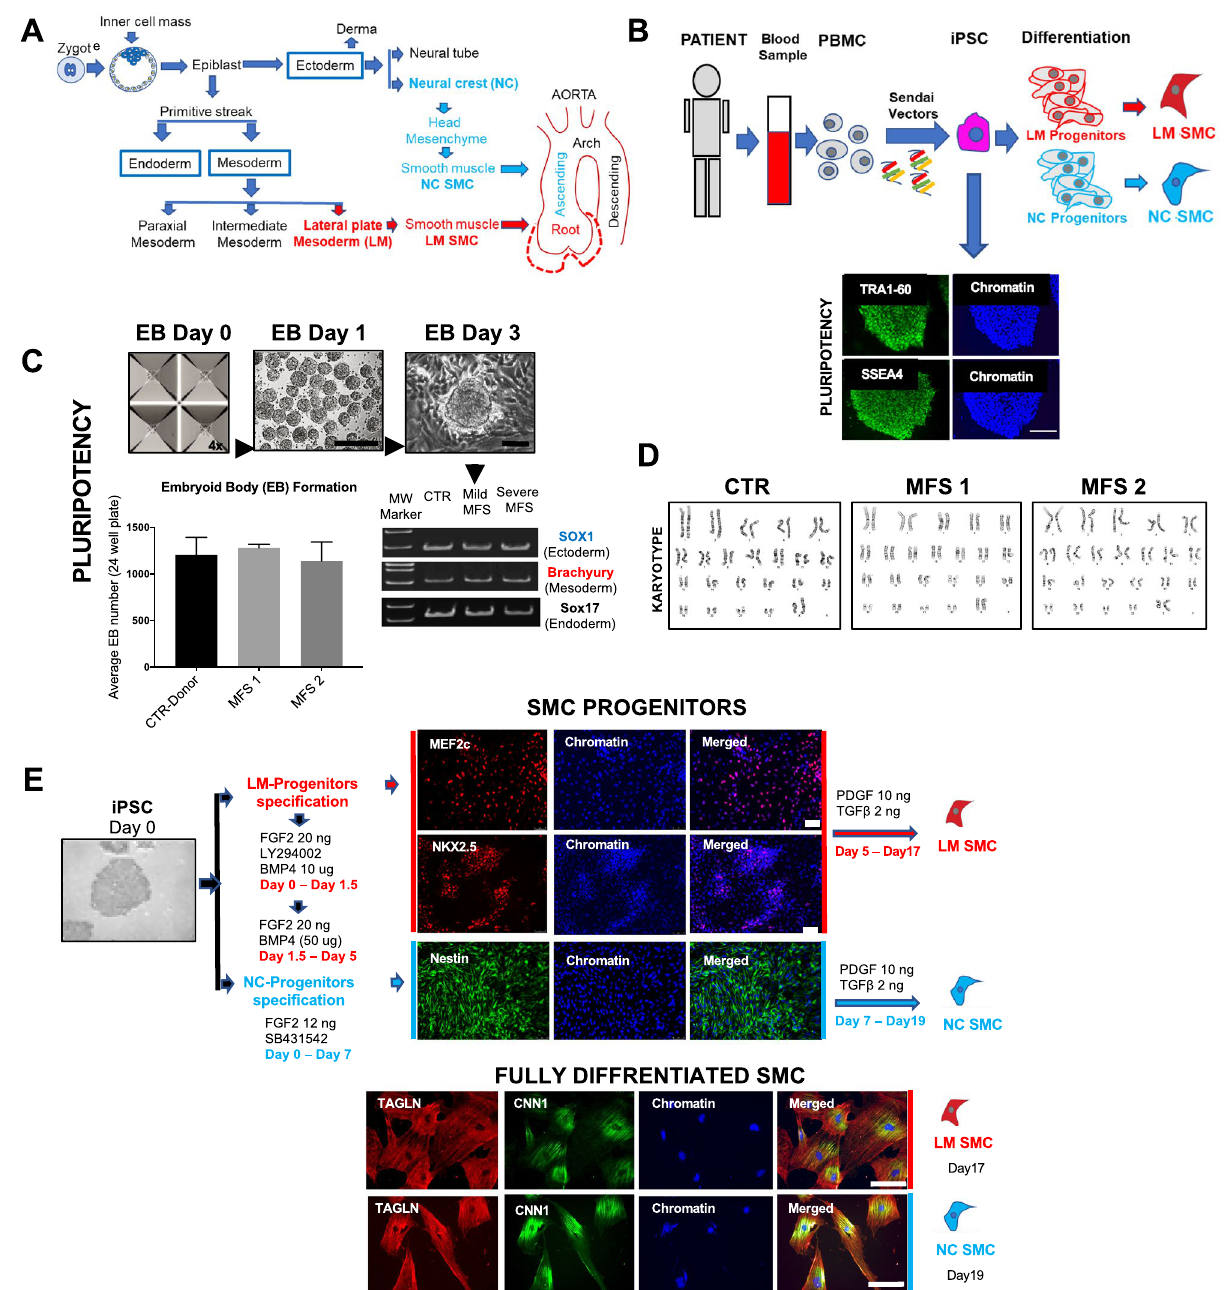
Figure 1. Peripheral blood mononuclear cells (PBMC) derived iPSCs differentiated into vascular smooth muscle cells (SMC) can model Marfan syndrome disease, in vitro. ( A ) Brief description, lineages contributing SMCs to the thoracic aorta. While lateral mesoderm (LM) SMCs contribute to the aortic root structure, neural crest (NC) SMCs populate the ascending aorta. ( B ) PBMC reprogramming with Sendai virus vectors of OCT4, SOX2, Nanog and cMyc transcription factors to generate induced pluripotent stem cells (iPSC) which were further differentiated into LM and NC SMC progenitor cells. IPSCs stained positively for pluripotency markers TRA1-60 and SSEA4. ( C ) Embryoid body (EB) formation assay with representative photos of the AgreWell cell funneling system (day 0), embryoid bodies (spherical aggregates) at day 1 post culture and a representative EB with spontaneous differentiation at day 3. Bar graph shows the total number of spherical aggregates per iPSC line, formed in one well of a 24-well plate. Gel images demonstrate PCR results from EB for SOX-1 marker for ectoderm, Brachyury for mesoderm and SOX-17 for endoderm. ( D ) Representative karyotype (G-banding) for each iPSC line. ( E ) LM progenitor cells (MEF2C- and NKX2.5-positive) were generated from iPSC using AKT/PKB inhibitor (LY294002) and FGF2, then FGF2 and BMP4. NC progenitor cells (Nestin-positive) were generated from iPSC using an Activin/TGF-β1 inhibitor (SB431542) and FGF2 for 7 days. Cells were further differentiated into SMCs using PDGF-BB and TGF-β1 in a 12-day protocol. Resulting cells presented SMC phenotype, positive for transgelin (TAGLN) and calponin 1